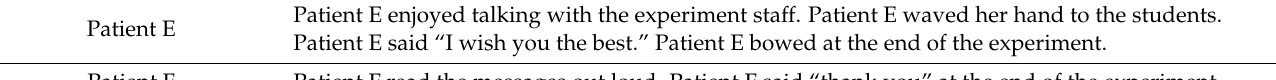
Table 15. Communication between the experiment staff and the patients in the principal outdoor ex- periment. Patient